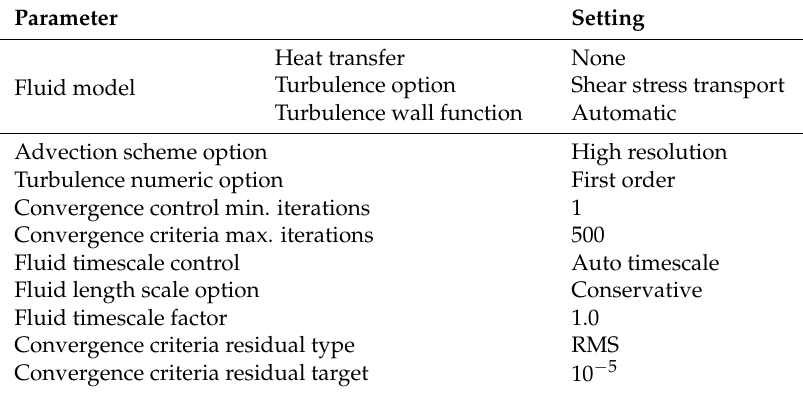
Table 2. Software analysis settings for performing simulation calculations.